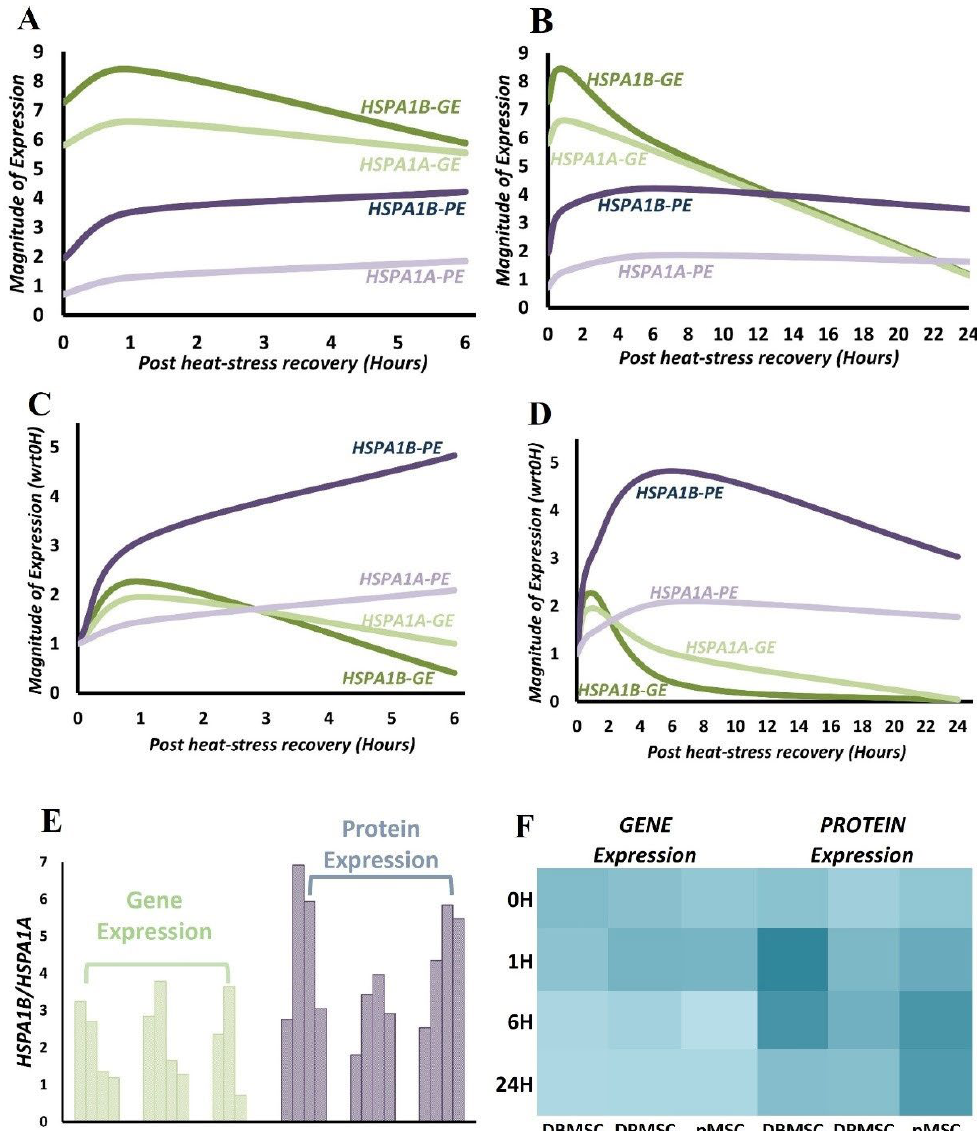
Figure 8. HSPA1B Expression Dominates HSPA1A Expression. (GE: Gene expression. PE: Protein expression) The time courses plotted here are from merged gene and protein expression Log 2 data for the three PDSCs. For each cell type, the results are at least from two individual experiments. ( A , B ) Smoothened scatterplot of the averaged Log 2 fold change in expression with respect to expres- sion in control cells. ( C , D ) Smoothened scatterplot of the averaged fold change in expression with respect to expression at 0H. ( E ) Ratio of HSAP1B expression to HSPA1A expression. ( F ) Heat-map representation of the HSPA1B/HSPA1A ratios. HSPA1B dominance is higher in protein expression and is very well observed even 24 h post-stress exposure.